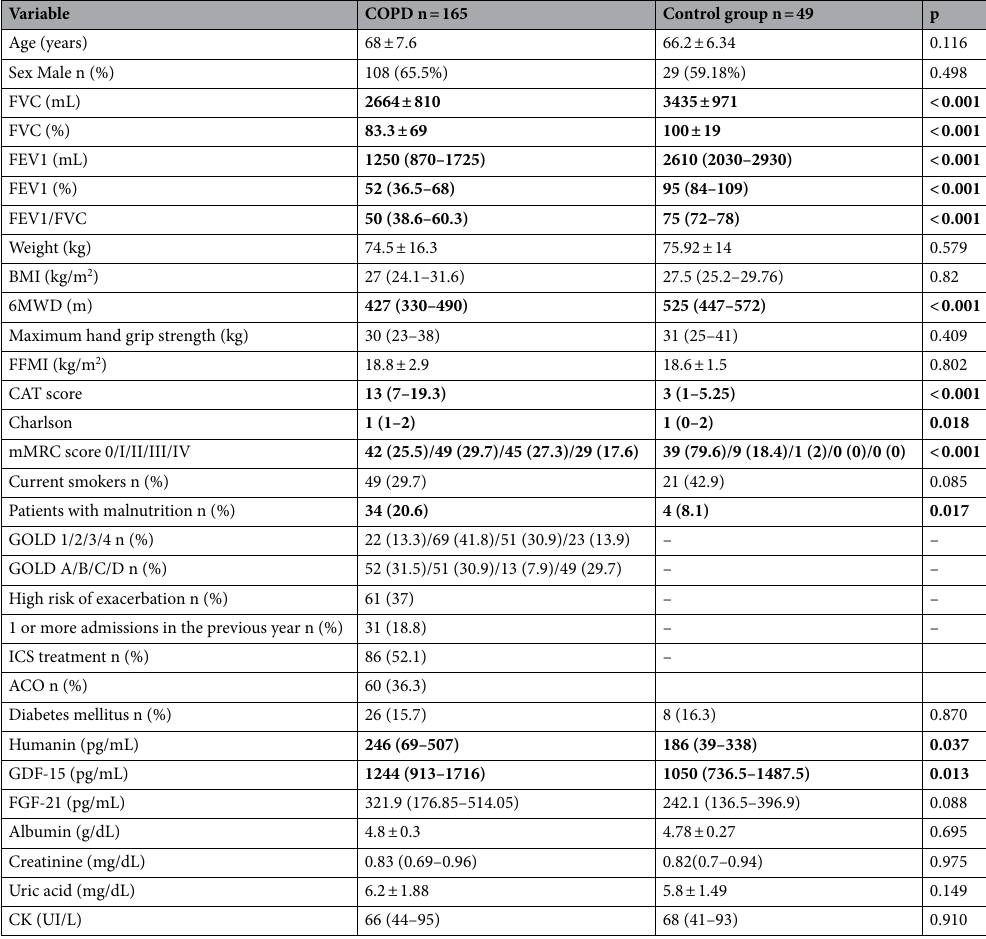
Table 1. Demographic, clinical and biochemical characteristics of controls and COPD patients. FVC forced vital capacity, FEV1 forced expiratory volume in the first second, mMRC modified Medical Research